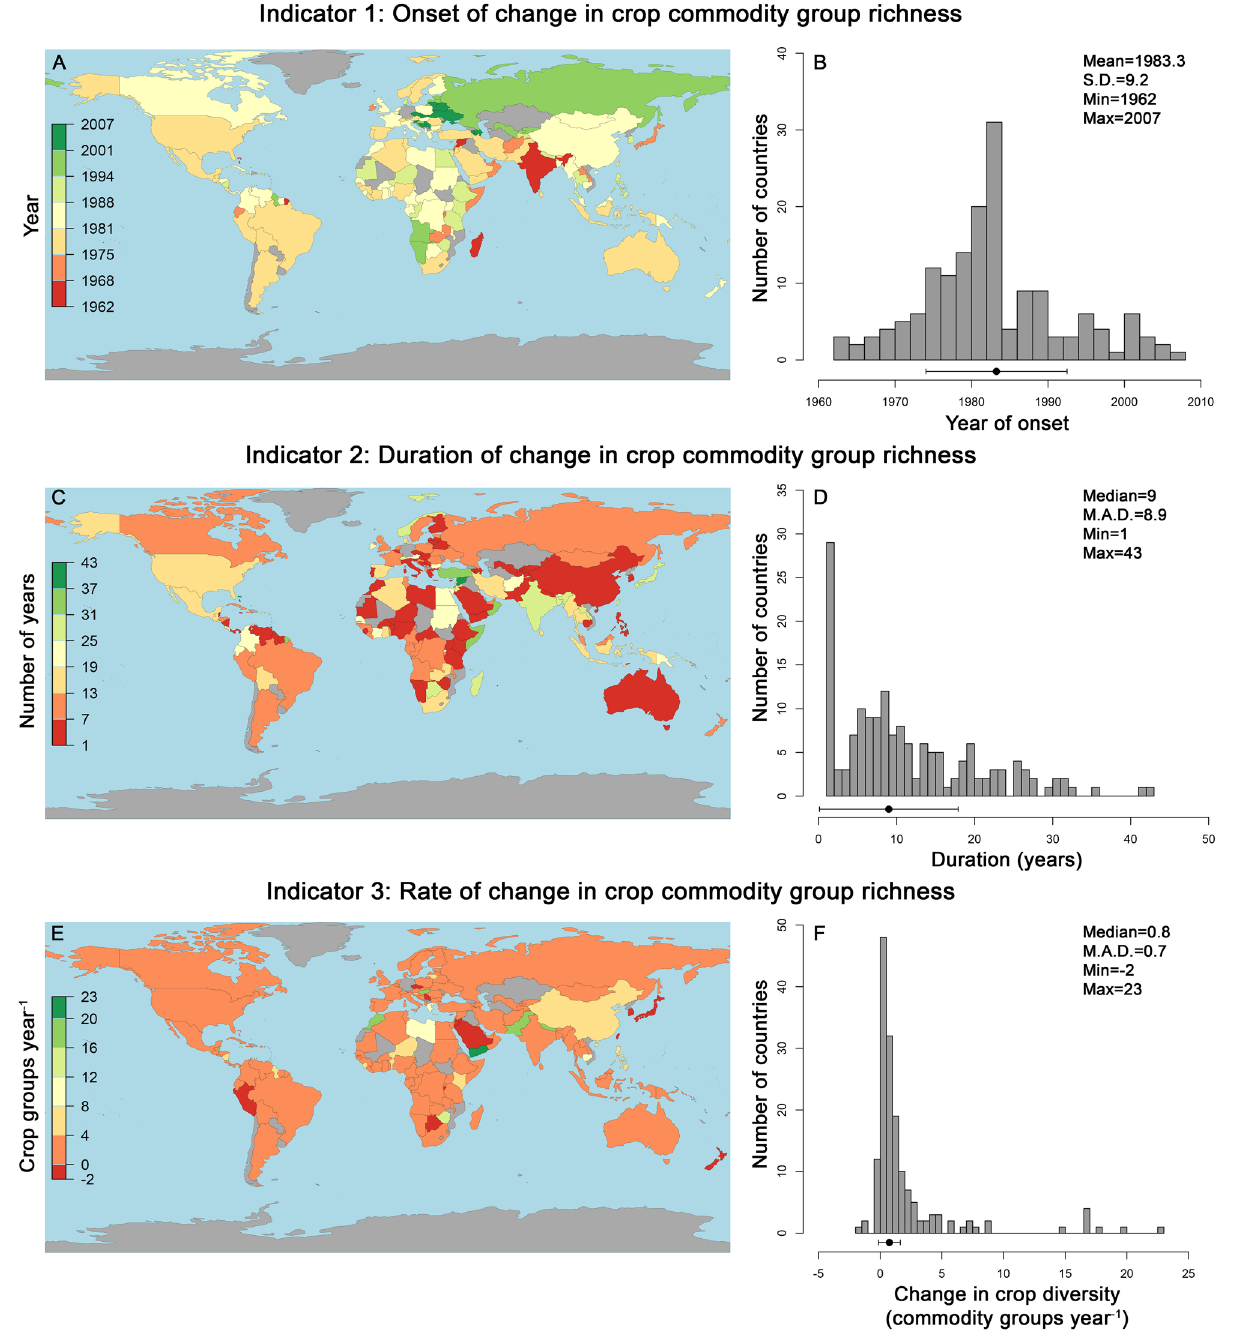
Figure 2. Maps and histograms of three indicators of crop commodity group richness ( S ) change across 165 countries. Values for all three indicators for each country were derived from piecewise linear models predicting S as a function of year (see Fig. 1 for example). Countries coloured gray in the maps were those where either data was not available or the piecewise models failed to converge (denoted in Table S1). Histograms and associated descriptive statistics for each indicator are also presented, with means (± s.d.) or medians (± m.a.d.) denoted visually by the points and error bars below the histograms. All piecewise model parameters for each country are presented in Table S1. Maps were generated using the mapCountryData function in the rworldmap R package 30